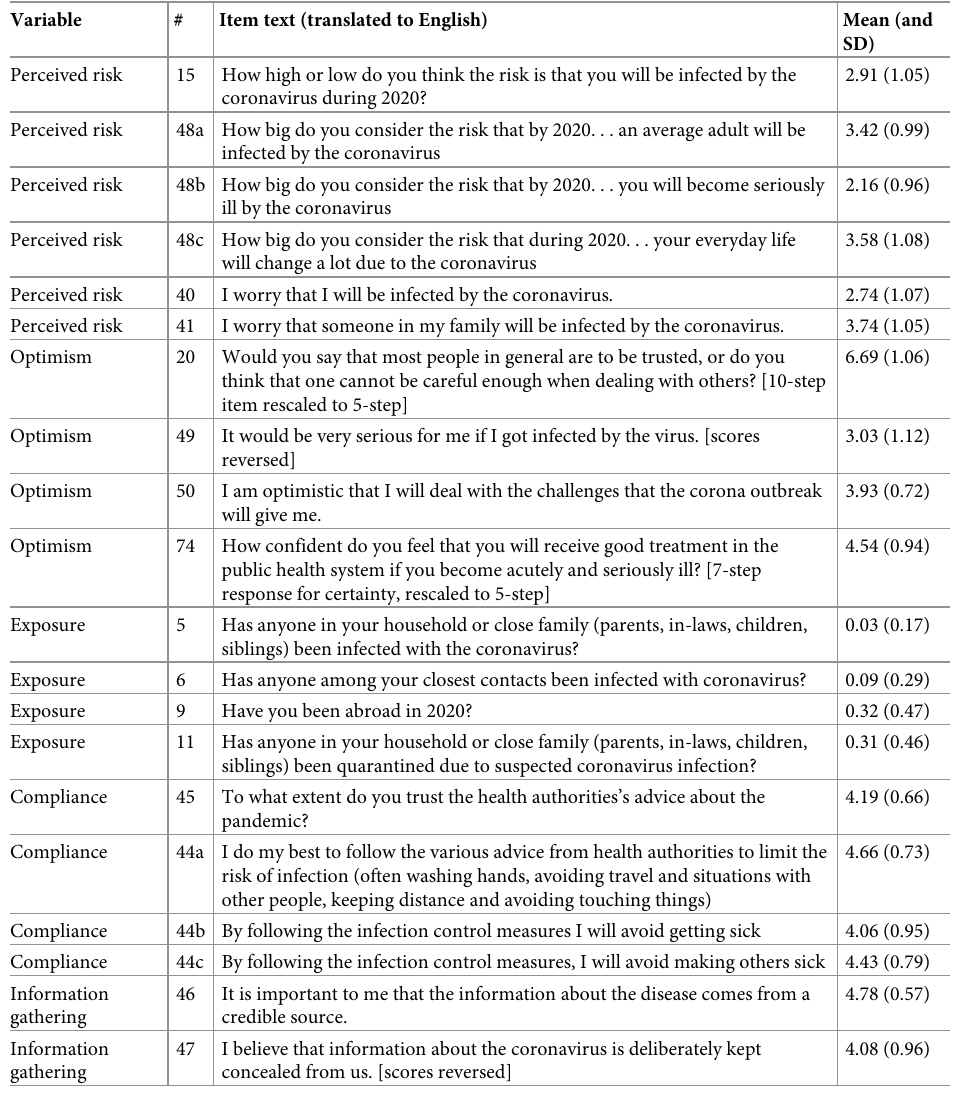
Table 1. List of items used in